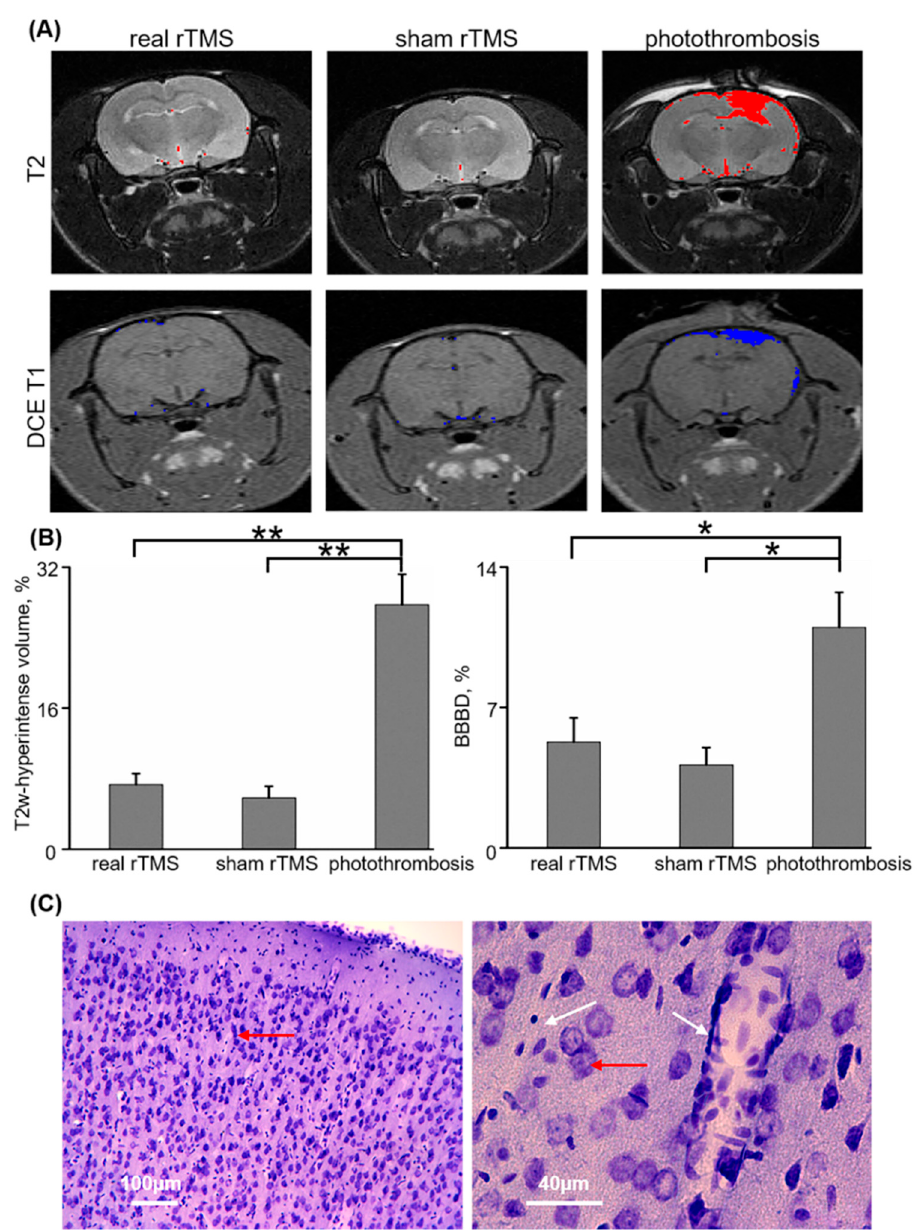
Figure 4. Repeated low-frequency rTMS does not result in brain injury: ( A ) Coronal T2-weighted (top) and T1-weighted (bottom) MRI of the rat head following 5 consecutive days of low-frequency rTMS, one session/day, delivered as either real (left) or sham (center) stimulation. Imaging was also carried out in animals that underwent photothrombosis-induced stroke, at 24 h post-infarct induction (right). Offline detection of hyperintense voxels in T2-weighted imaging (red, top, see Materials and Methods) and BBB dysfunction voxels in T1-weighted imaging (blue, bottom) are overlaid. ( B ) Left: mean ± SEM relative volume of hyperintense brain region in T2-weighted (T2w) imaging. Right: mean ± SEM relative BBB dysfunction (BBBD) volume in dynamic contrast-enhanced (DCE) T1-weighted imaging. ( C ) Microscopic images (left: ×10, right: ×40) of coronal slices dissected from the right primary motor cortex in real rTMS-treated animals, stained with cresyl-violet (see Materials and Methods). Neuronal cell bodies (red arrow) appear alongside brain vasculature (white arrow). * p < 0.05, ** p < 0.01.